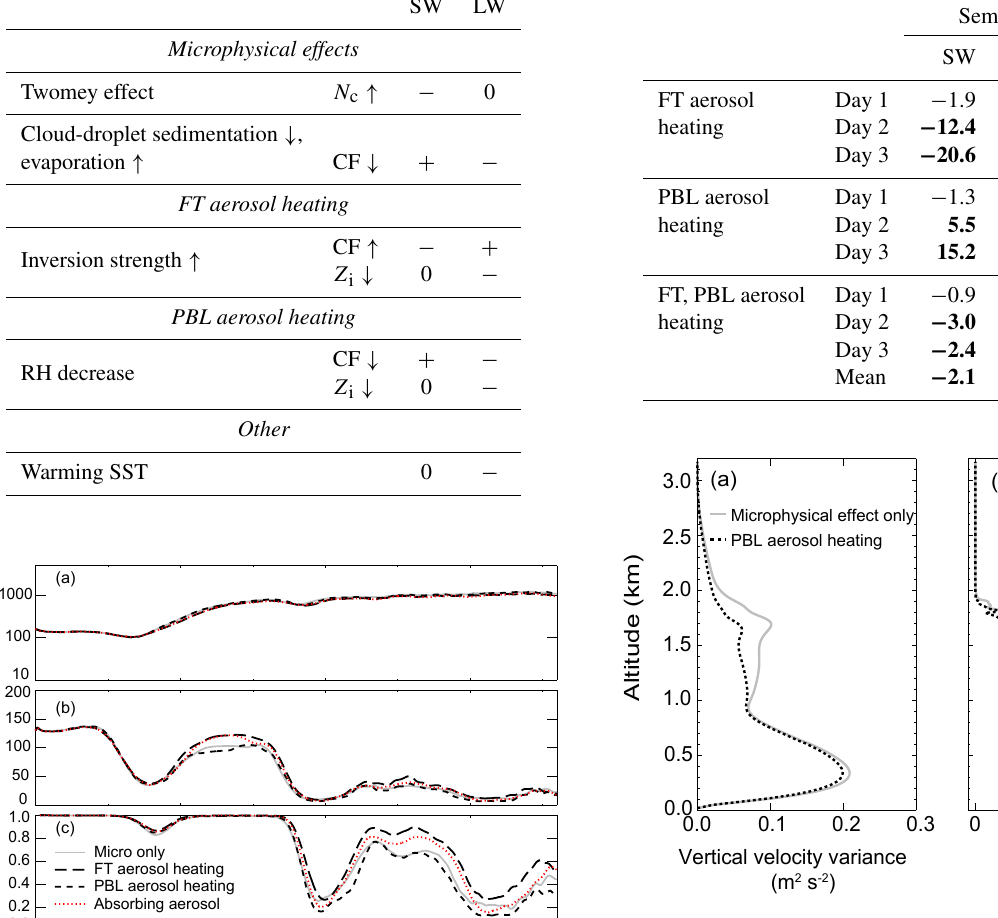
Figure 6. Horizontally averaged profiles of (a) vertical velocity variance and (b) total water flux averaged over 10:00 to 14:00 lo- cal time on day 3 for simulations with (gray solid line) and with- out (black dotted line) absorbing aerosol affecting radiation in the PBL. Both simulations include microphysical effects of the en- trained aerosol